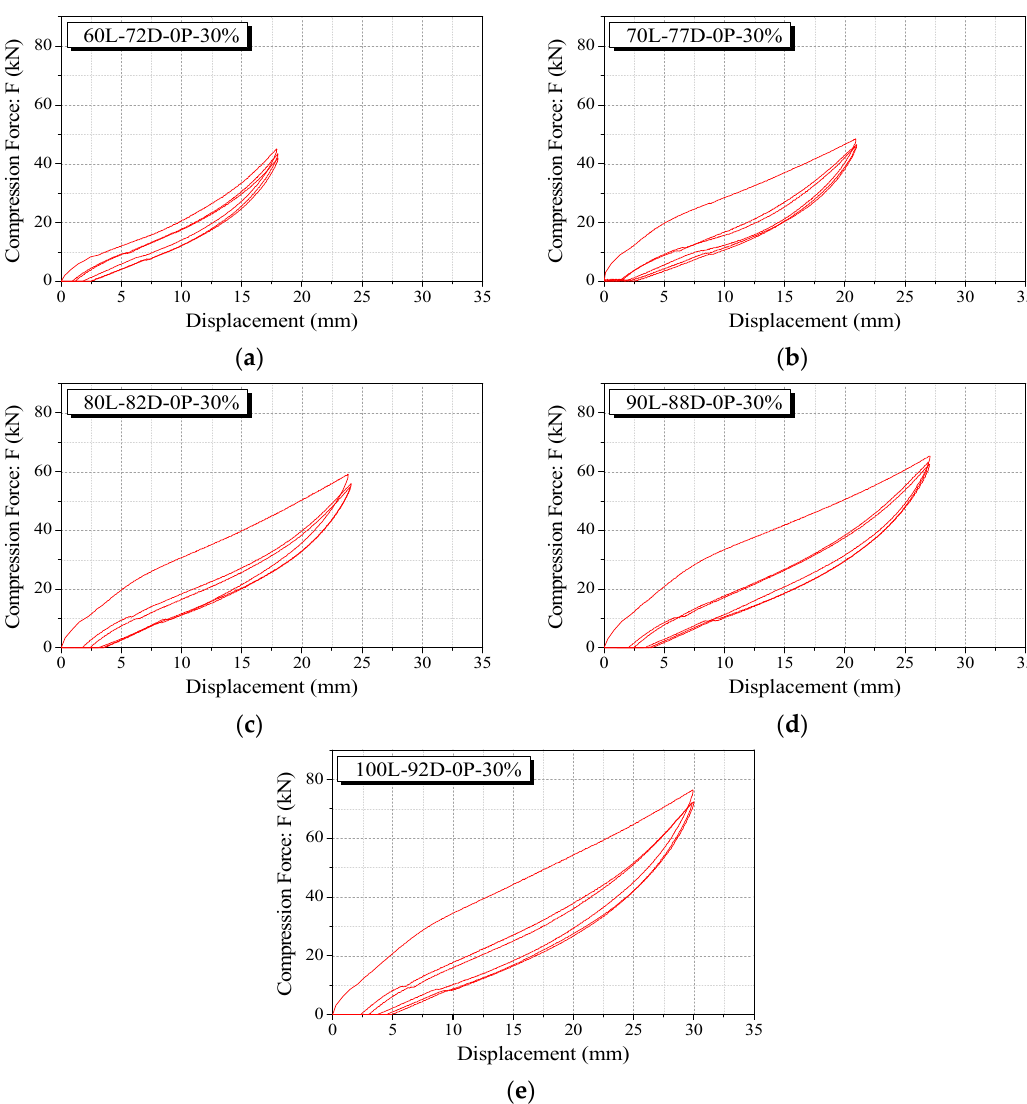
Figure 5. Compressive behavior without precompression (Type 1 specimens). ( a ) 60L-72D-0P-30%; ( b ) 70L-77D-0P-30%; ( c ) 80L-82D-0P-30%; ( d ) 90L-88D-0P-30%; ( e ) 100L-92D-0P-30%.